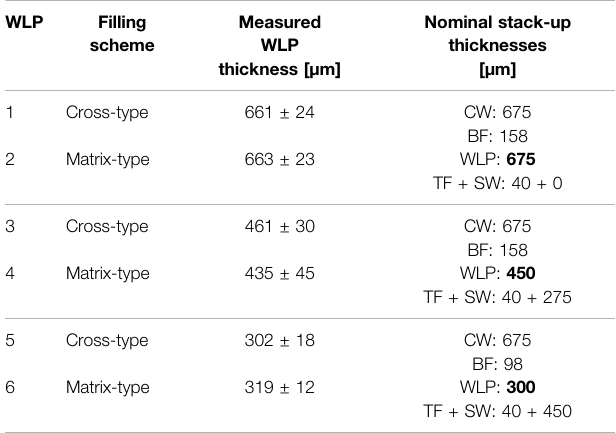
TABLE 1 | Properties of the six WLP wafers produced by MicroFabSolutions together with the nominal values of the stack-up parts. In the “ nominal thickness ” column is giventhefullstackputintothemoldcavity:CarrierWafer(CW),Te fl onFilm(TF),Bonding Film (BF), dies plus resin (WLP), Spacer Wafer